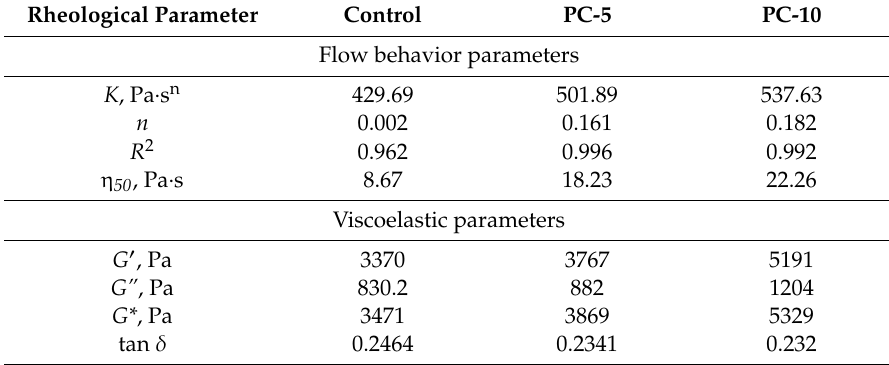
R 2 —correlation coe ffi